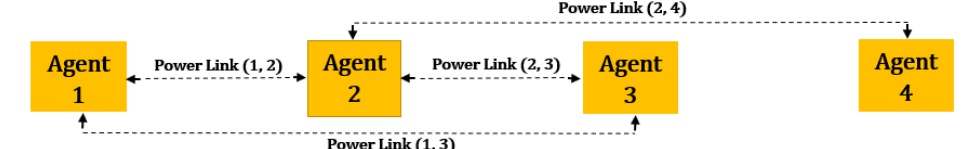
Figure 12. Topology-based multiagent communication of multi-smart microgrids power network .